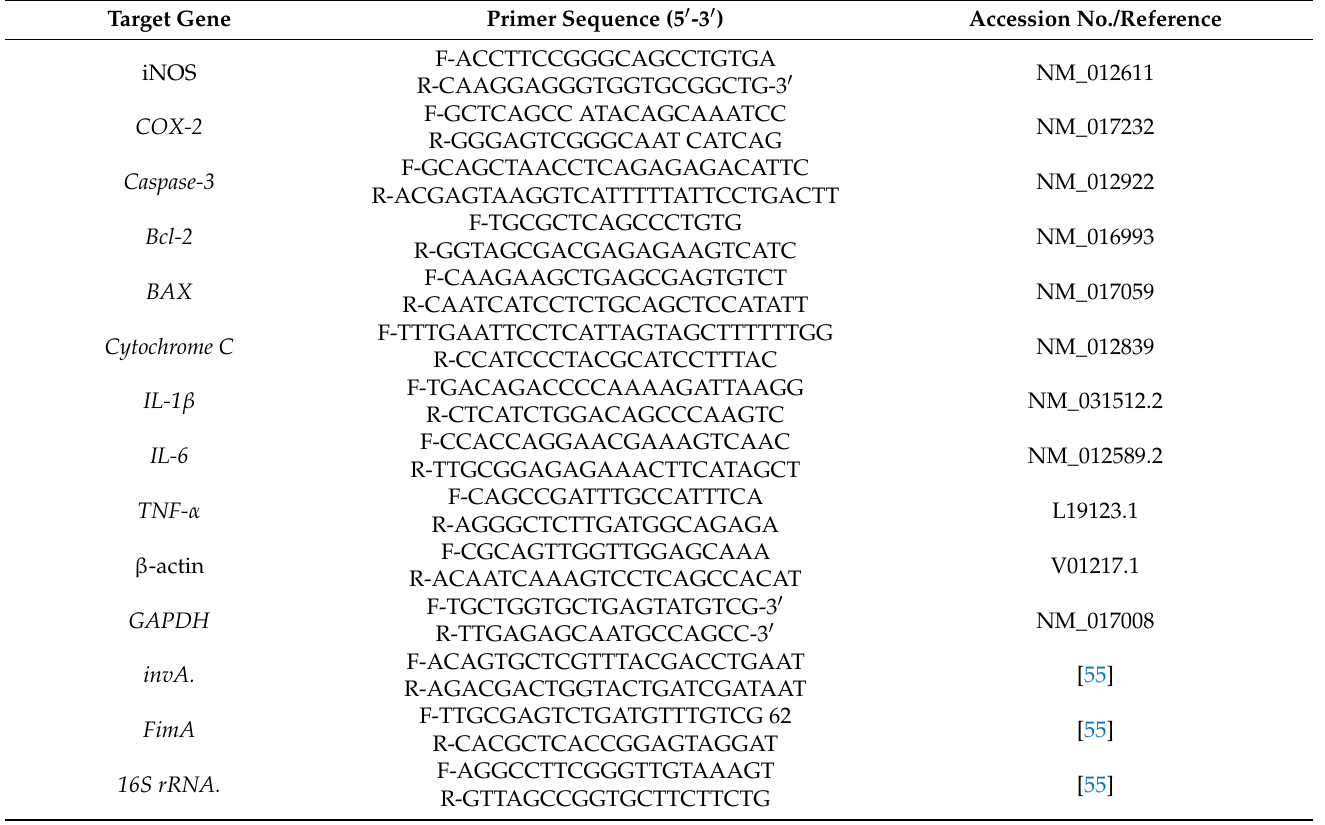
Table 3. Primer sequences utilized for rRT-PCR analysis of targeted gene